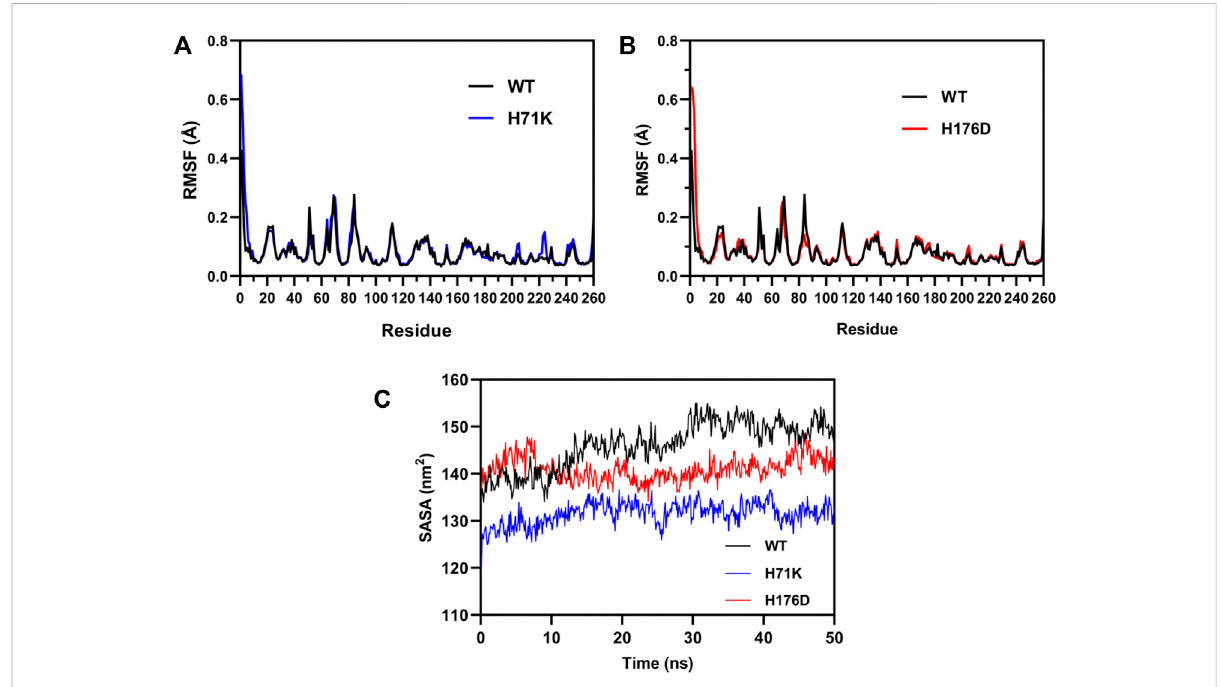
FIGURE 6 MD simulations for the wild-type enzyme and mutants. RMSF computed from MD simulations for the wild-type enzyme and mutant H71K (A) and H176D (B) at 300 K for 100 ns. (C) SASA of the WT and mutants H71K and H176D changed with simulation time over 50 ns at